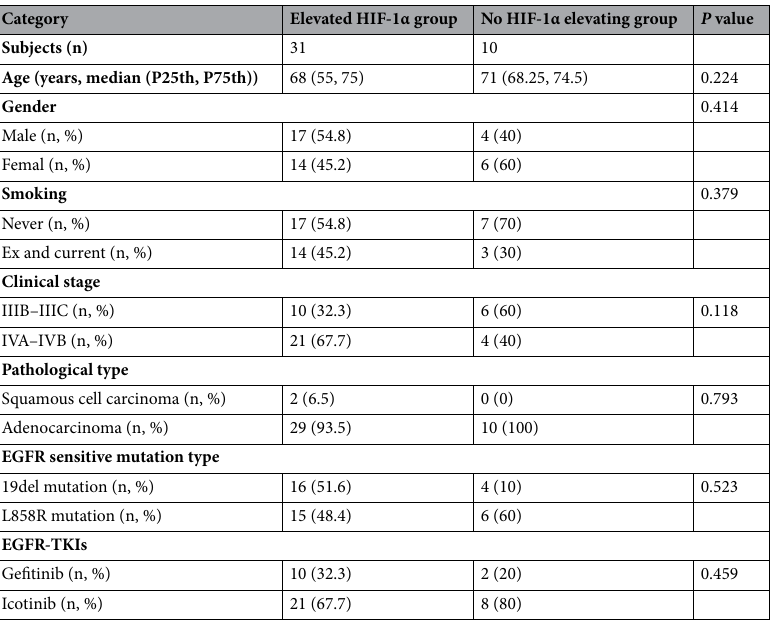
Table 4. The clinical characteristics comparison of elevated HIF-1α group and no HIF-1α elevating group in 41 patients receiving a second biopsy.